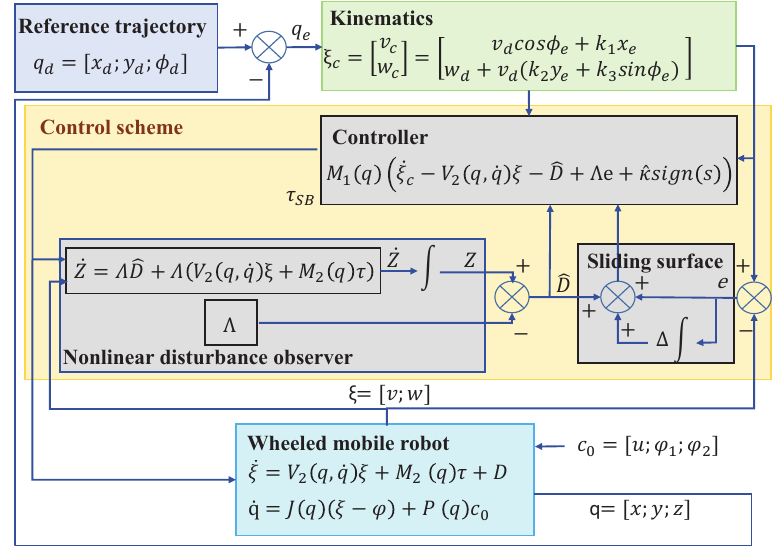
Figure 2. Block diagram of the NDOISMC frame.